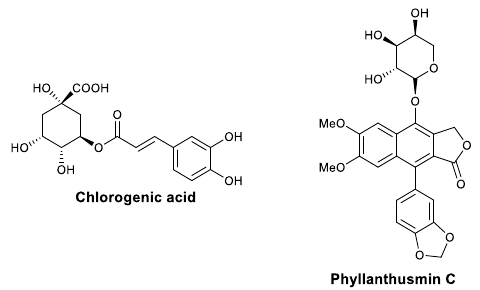
Figure 11. Structures of chlorogenic acid and phyllanthusmin C.